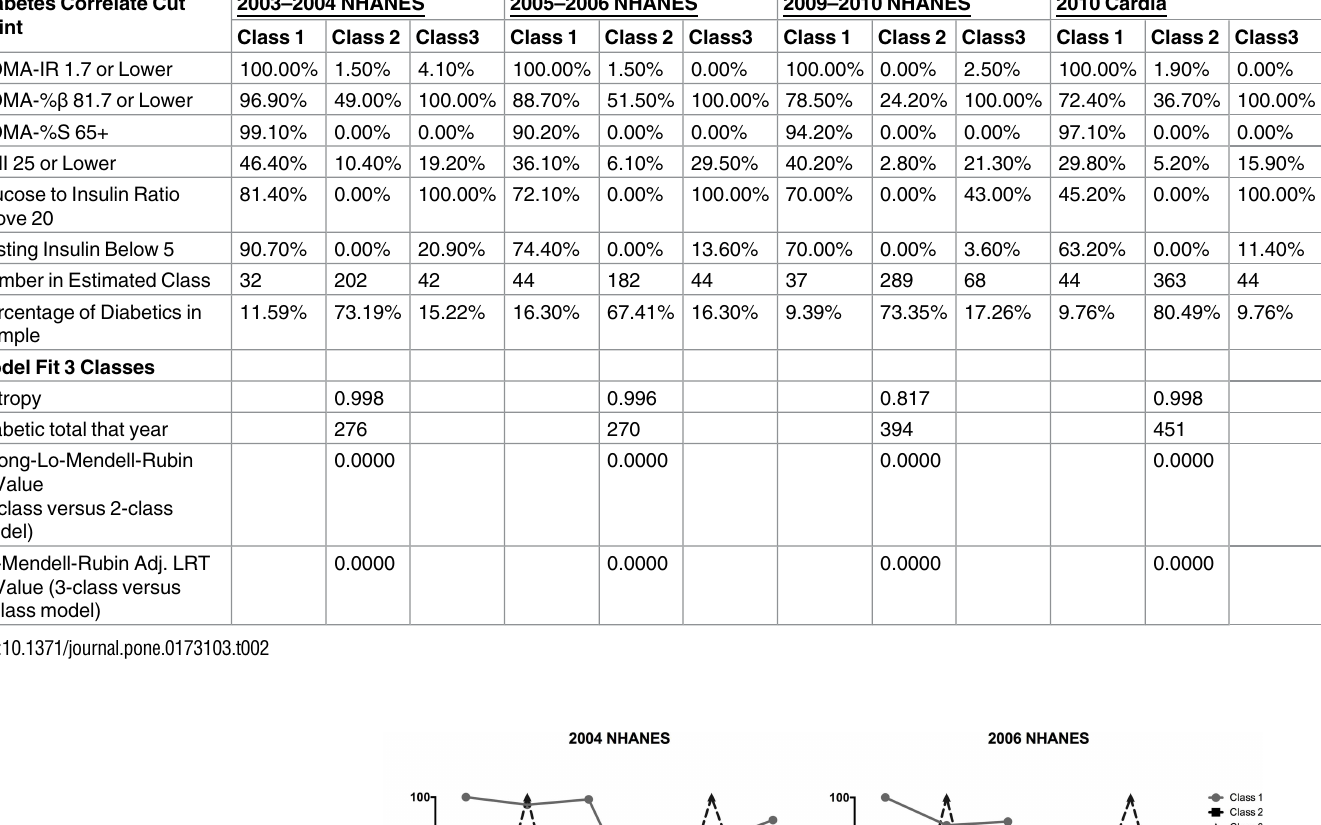
Table 2. Latent class analysis of the Diabetes Typology Model. Diabetes Correlate Cut Point